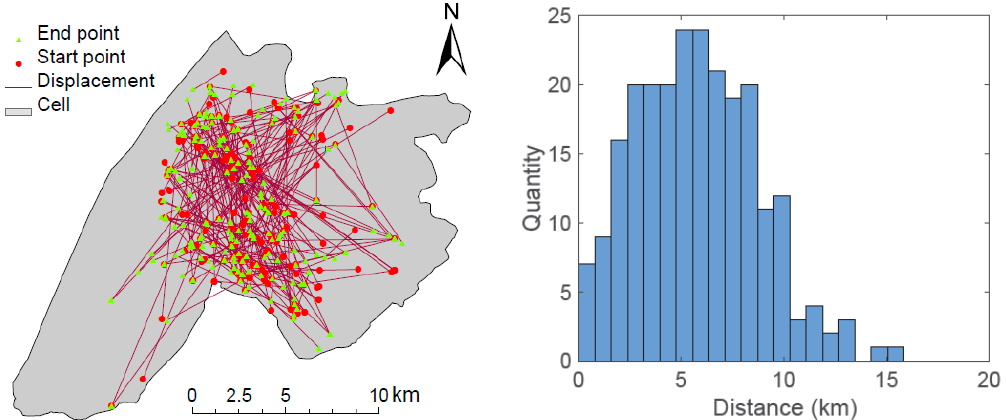
Figure 4. Displacements (significance < .001) and histogram of the distances.